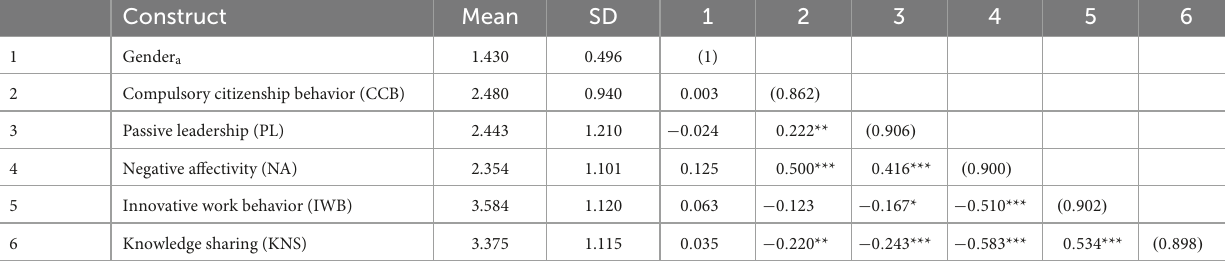
TABLE 2 Discriminant validity, correlations, and descriptive statistics.